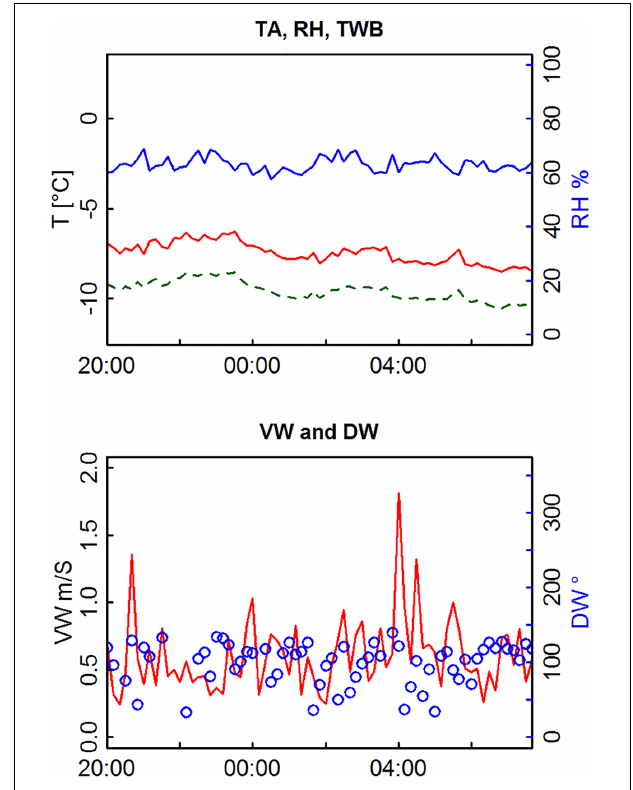
FIGURE 3 | Meteorological measurements: air temperature (TA, red line upper panel), relative humidity (RH, blue line), wind speed (VW, red line lower panel), and wind direction (DW, blue circles) for experiment February 11/12, 2016. Wet-bulb temperature (TWB, green dashed line) was calculated from TA and RH (Stull, 2011). Hours are in local